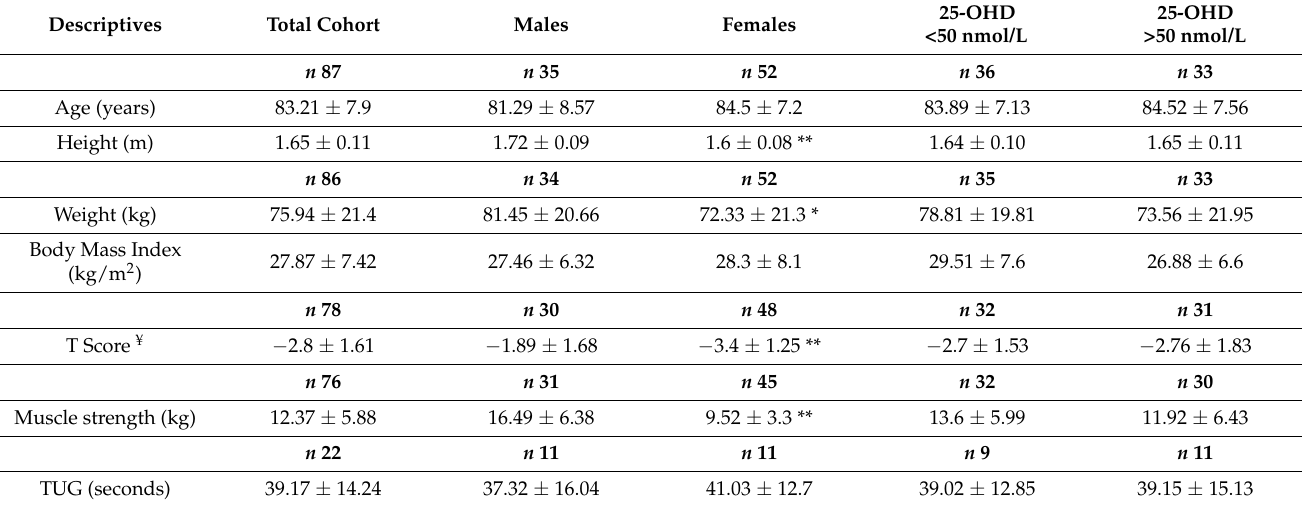
Table 2. Descriptive characteristics of care home